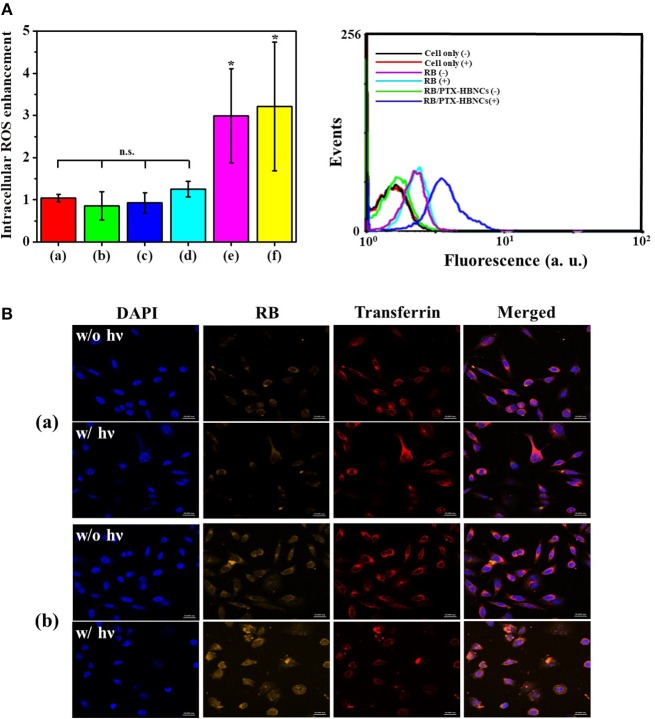
(A) Flow-cytometric analyses of intracellular ROS generation within Tramp-C1 cells of different treatment. The levels of intracellular ROS were determined using DCFH-DA (5 μM). (Left) The elevated cytosolic ROS (F/F0) of (a) non-treated cells, and cells incubated with (b) RB, (c) HBNCs, (d) PTX-HBNCs, (e) RB-HBNCs, (f) RB/PTX-HBNCs, respectively. The DCF signal of irradiated cells (F) was compared to that kept in darkness (F0). (Right) Representative histograms of non-treated cells, RB-treated cells and (RB/PTX-HBNCs)-treated cells in response to a red light irradiation (632 nm, 15 mW/cm2) for 1 h. (B) Confocal microscopic images of Tramp-C1 cells treated with (a) RB and (b) RB/PTX-HBNCs, respectively. RB concentration was fixed at 20 μM. After incubation in culture medium (10% FBS) for 6 h, cells were exposed to a red light for 1 h. Scale bar: 20 μm. n.s. > 0.05 and *p < 0.5 vs. non-treated cells.